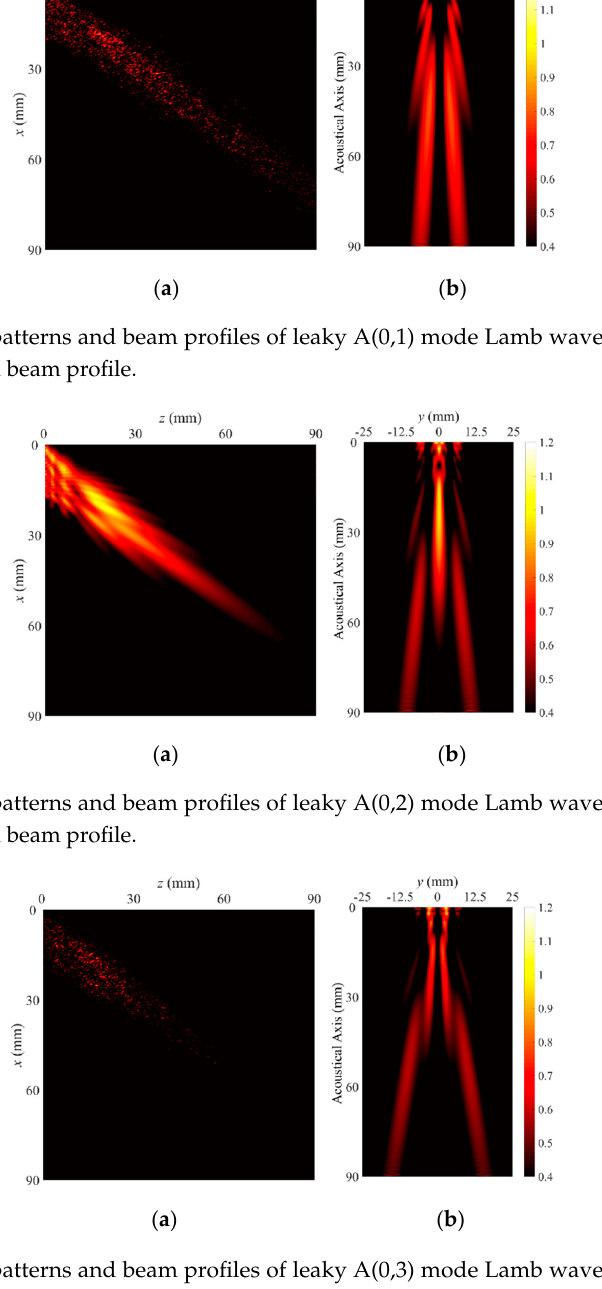
Figure 8. Radiation patterns and beam profiles of leaky A(0,3) mode Lamb wave, ( a ) vertical beam profile, and ( b ) lateral beam profile.